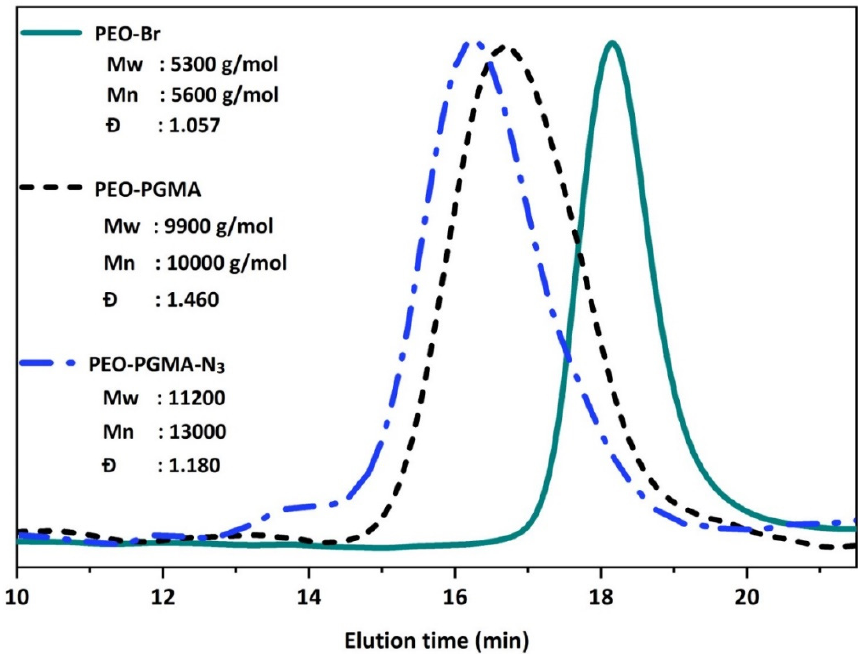
Figure 2. GPC chromatogram of PEO ‐ Br, PEO ‐ b ‐ PGMA and PEO ‐ b ‐ PGMA ‐ N 3.